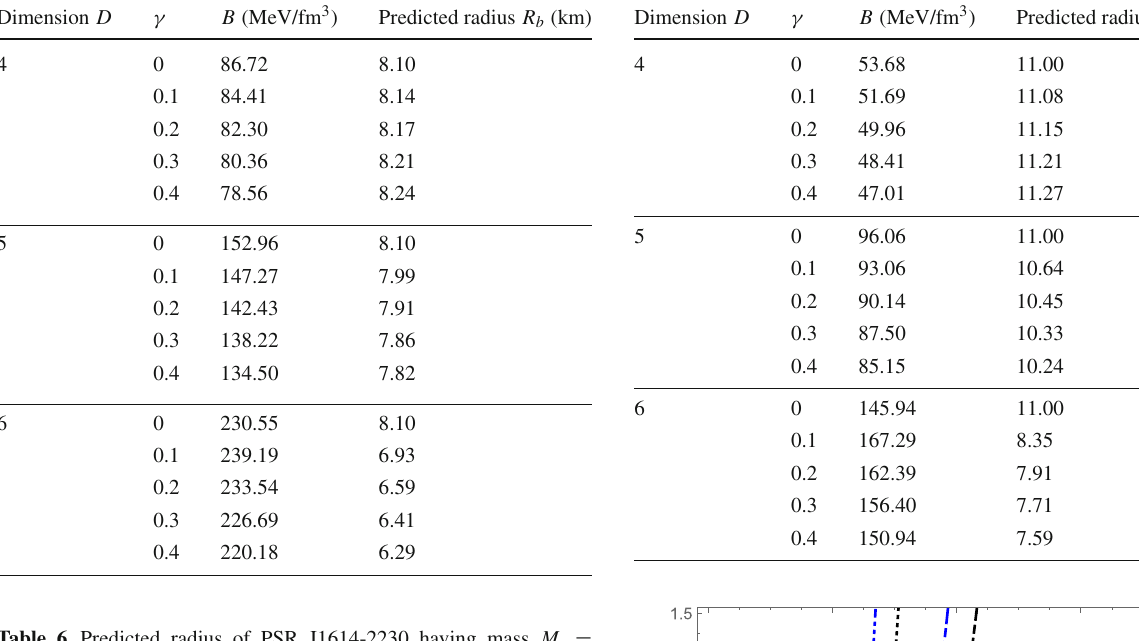
Table 6 Predicted radius of PSR J1614-2230 having mass M = 1.97 M (cid:2) . Here the bag parameter ( B ) is defined at the surface of the compact object where radial pressure vanishes. The pressure anisotropy parameter ( α ) is taken as unity Dimension D